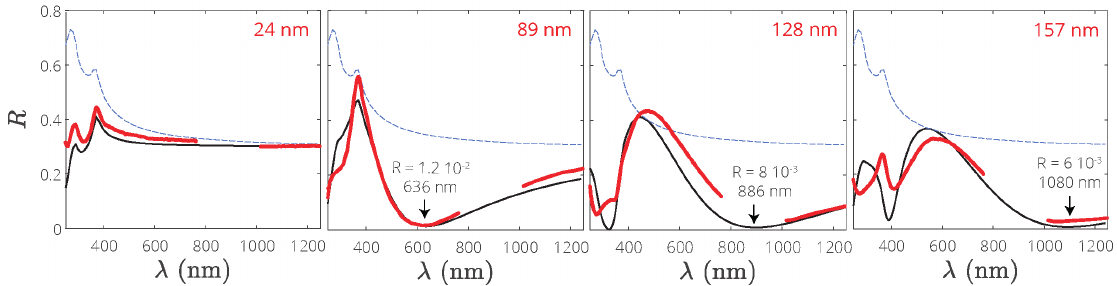
Figure 5. Intensity reflection coefficient R against wavelength for four different coating thickness (values given in red); in red the measurement, in black the calculation according to Equation (1) with no free parameter, in dashed blue the reflection coefficient of a bare silicon substrate. The value of R denoted by the arrow is the best extinction calculated from Equation (1) in the visible to near-infra-red (IR)